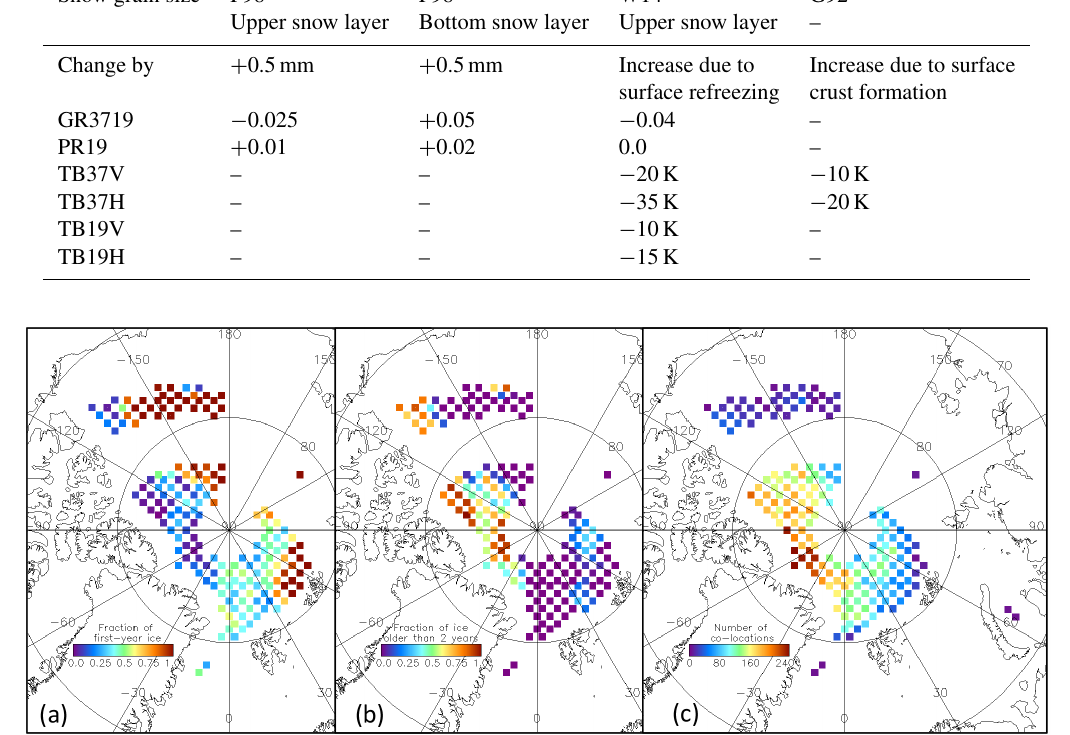
Figure 1. Spatial distribution of the MODIS sea-ice parameter data set superposed with the fraction of first-year ice (a) , multiyear ice (b) , and the number of co-located daily MODIS sea-ice parameter data for the entire period June–August (c)